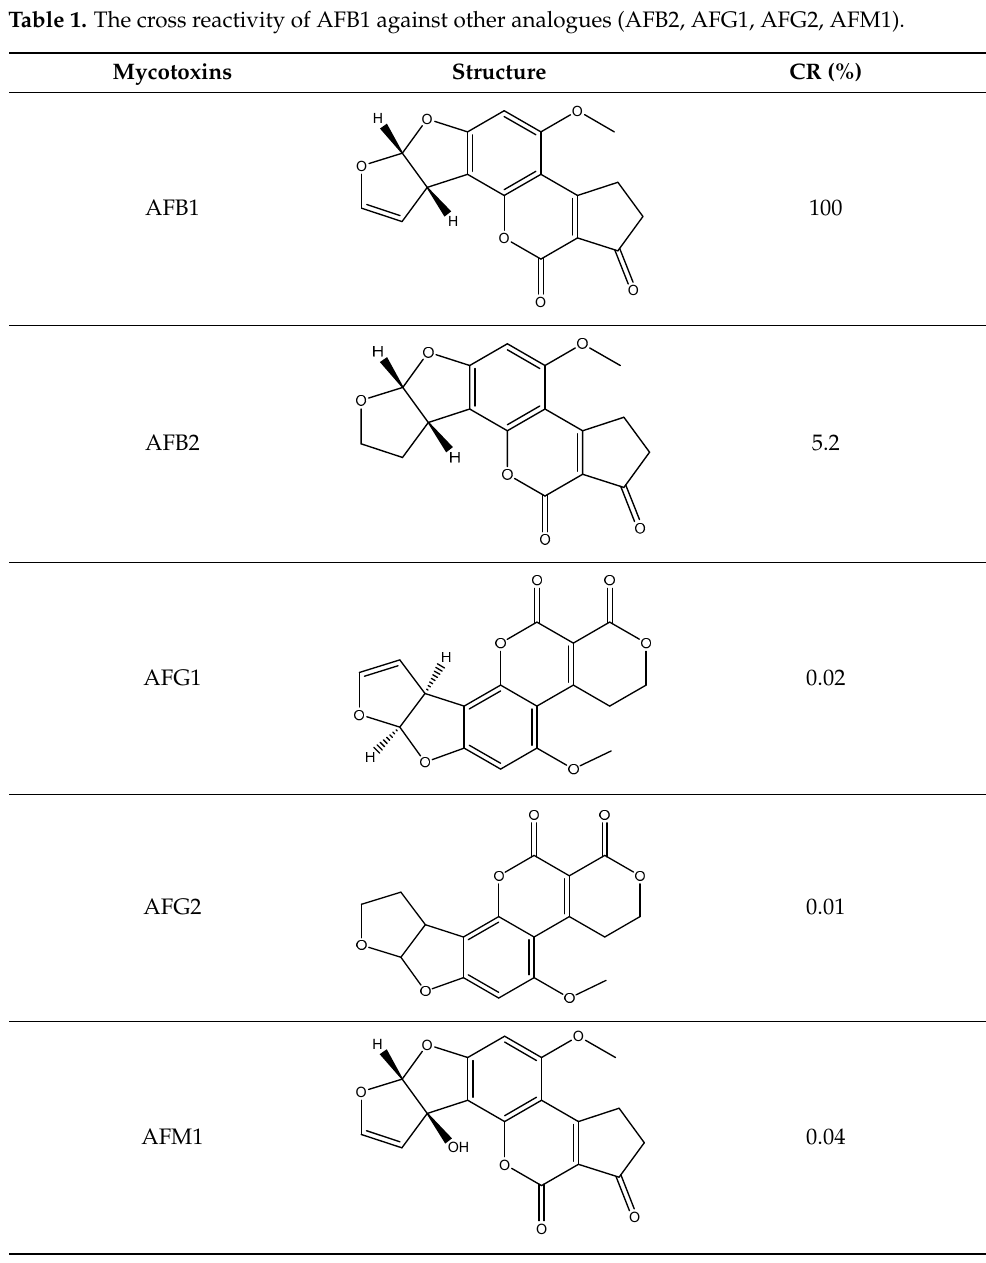
Table 2. The recovery rates of LFIA for AFB1 determination ( n = 6).